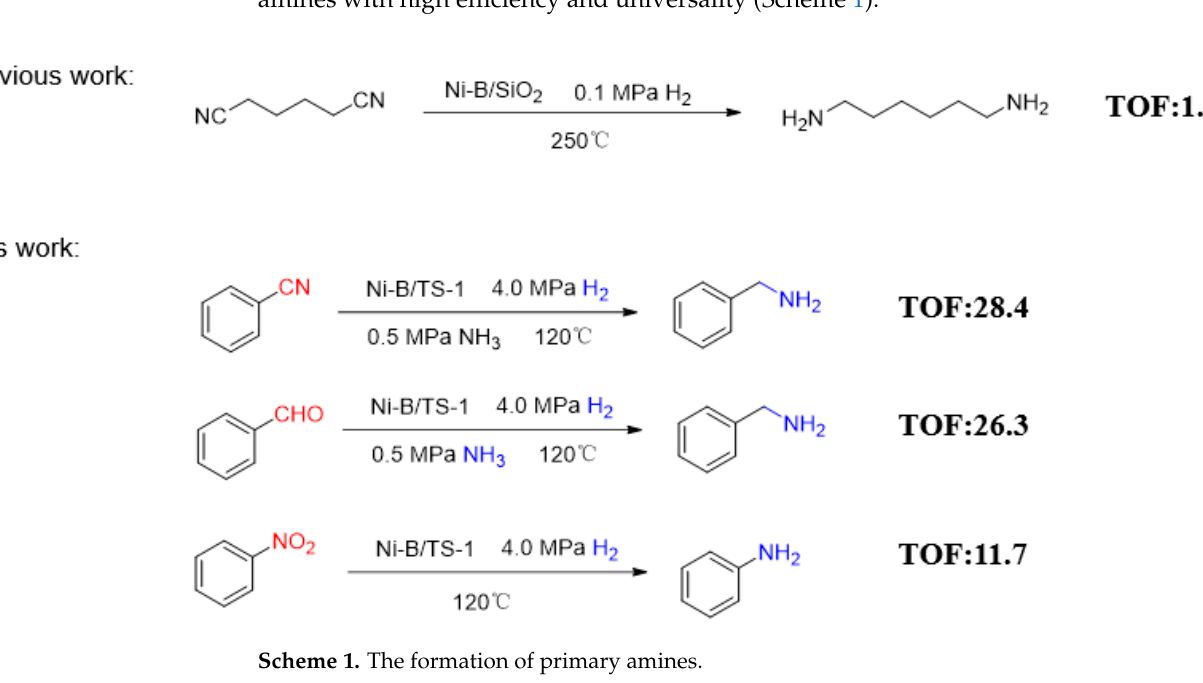
Table 1. Catalyst screening for benzonitrile a .